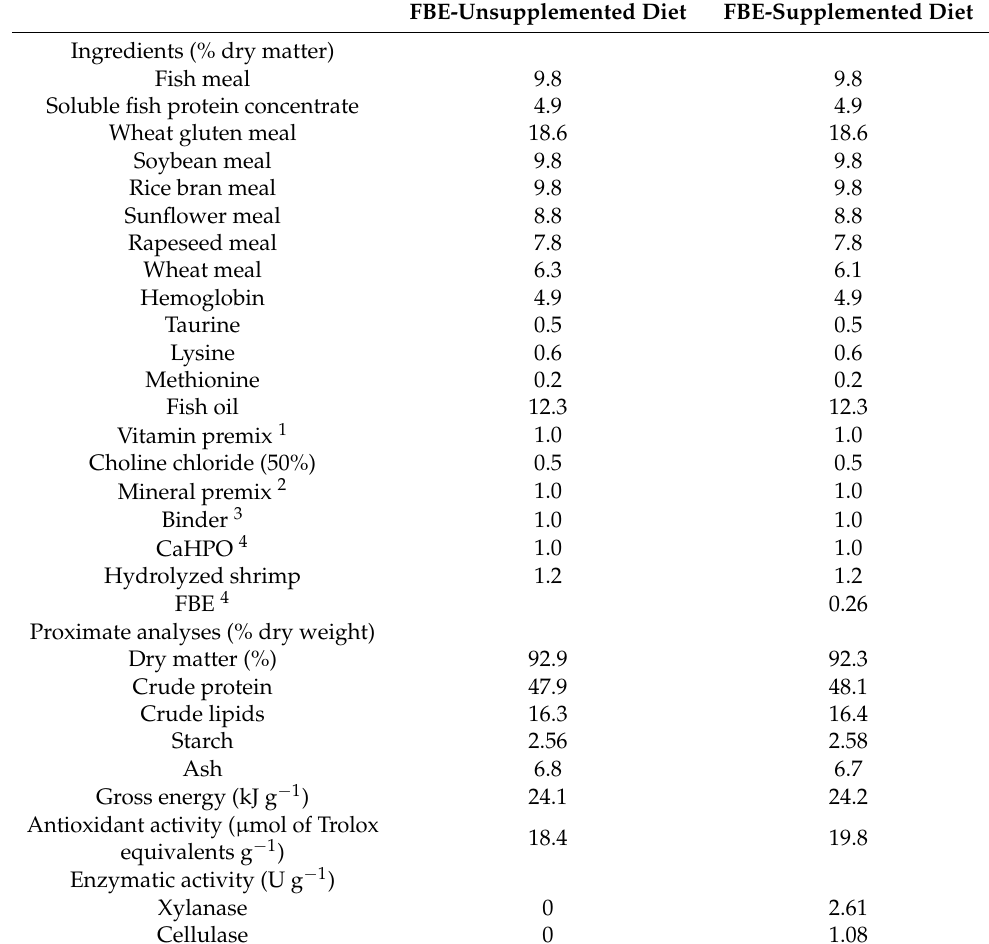
Table 1. Ingredient and proximate analyses of experimental